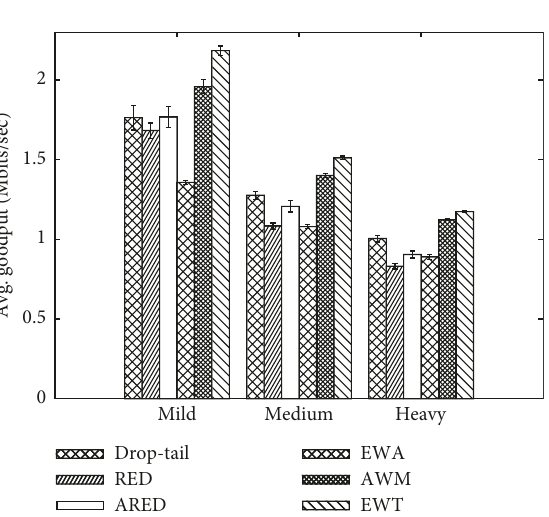
Figure 14: Average goodput: Scenario